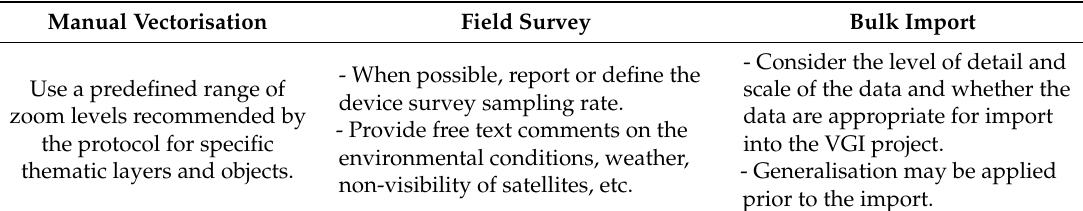
Table 1. Instructions to contributors on Level of detail/scale in relation to the data collection method. Manual